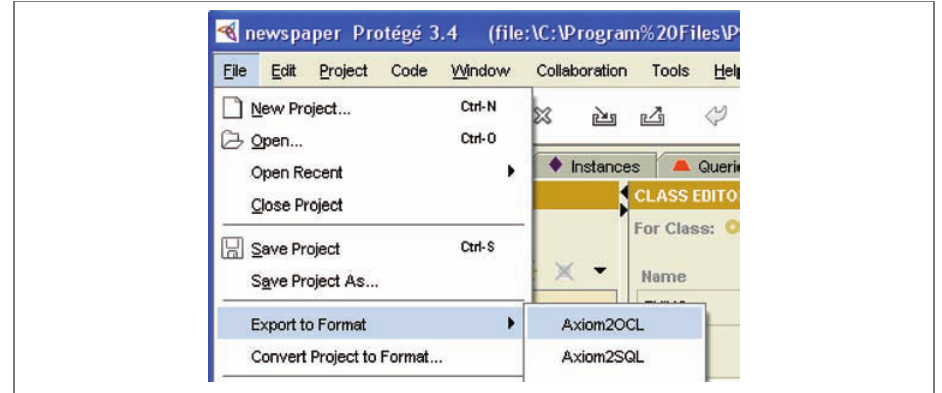
Fig. 2 . The Axiom2SQL